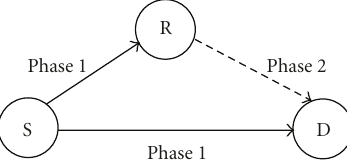
Figure 1: A typical scenario model in